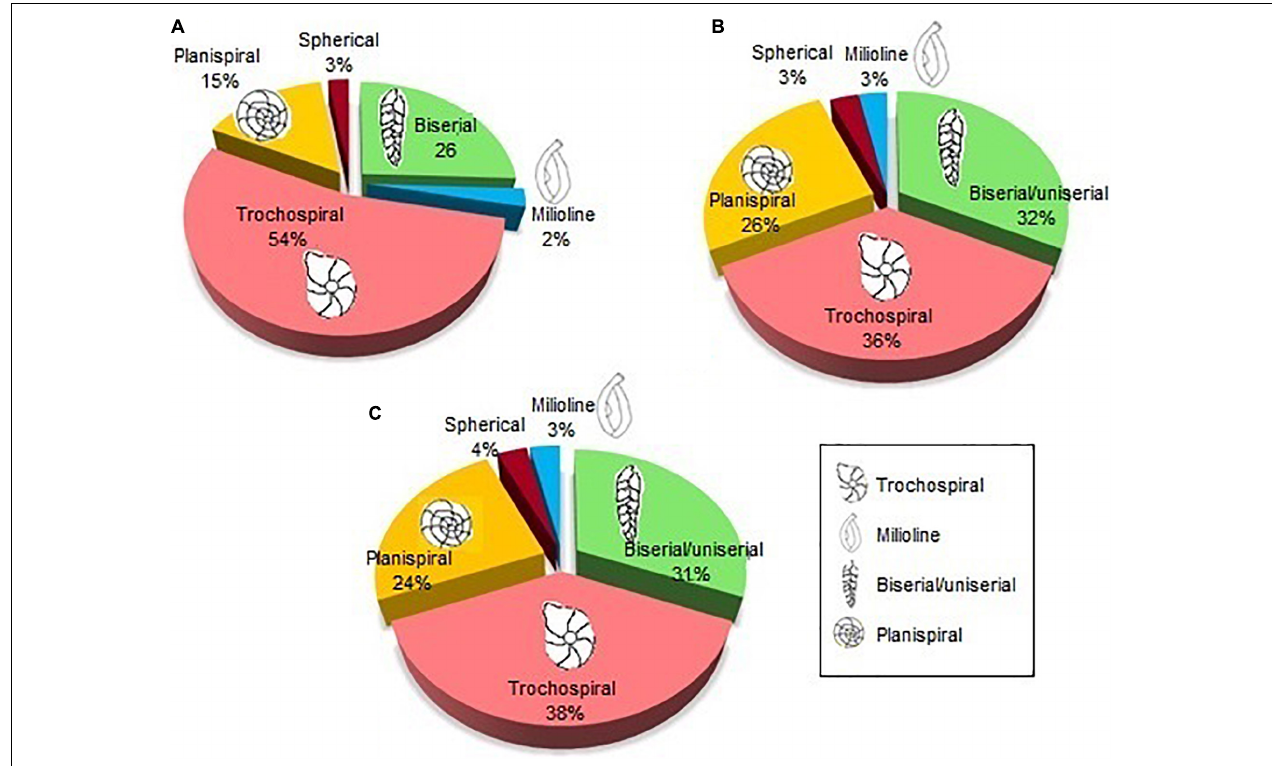
FIGURE 7 | Morphogroups found in samples on the (A) spatial distribution; (B) vertical distribution—core Z1A; and (C) vertical distribution—core